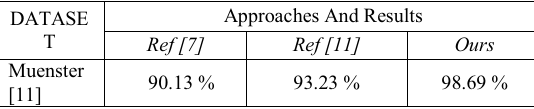
Table2. Average Time Cost In Seconds DATASE